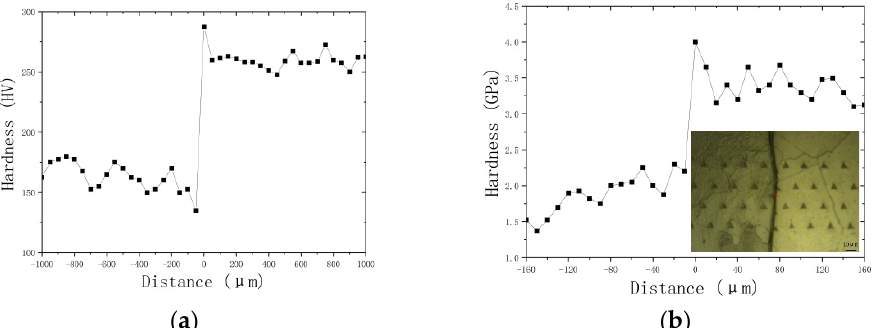
Figure 9. Microhardness and nanoindentation hardness profiles of the bonded joints: ( a ) the micro- hardness profile across the interface; ( b ) the nanoindentation hardness profile across the interface.